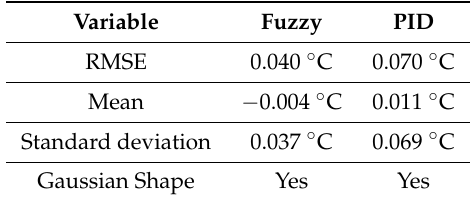
Table 5. Results for the internal temperature emulation.